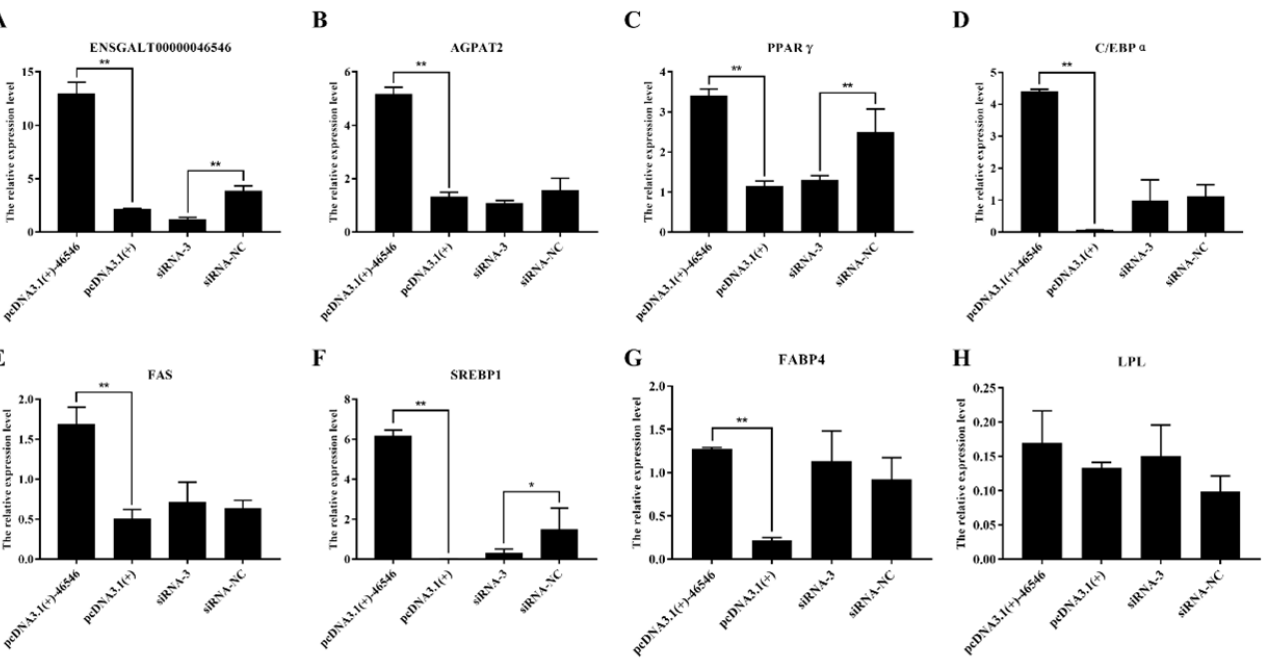
Figure 7. lncRNA-46546 promotes the expression of some genes and inhibits the proliferation of ICP2 cells. (A) The expression levels of lncR - NA-46546 after different treatments. (B) to (G) lncRNA-46546 promoted the expression of the AGPAT2 , PPARγ , C/EBPα , FAS , SREBP1 , and FABP4 genes. (H) lncRNA-46546 did not affect the expression of the LPL gene. ** Denotes p<0.01. * Denotes p<0.05. (ICP2, immortalized chicken preadi - pocyte 2; AGPAT2, 1 -acylglycerol-3-phosphate-O-acyltransferase 2; PPARγ , peroxisome proliferator-activated receptor γ; C/EBPα , CCAAT enhancer binding protein alpha; FAS , fas cell surface death receptor; SREBP1 , sterol regulatory element binding transcription factor 1; FABP4 , fatty acid bind- ing protein 4; LPL , lipoprotein